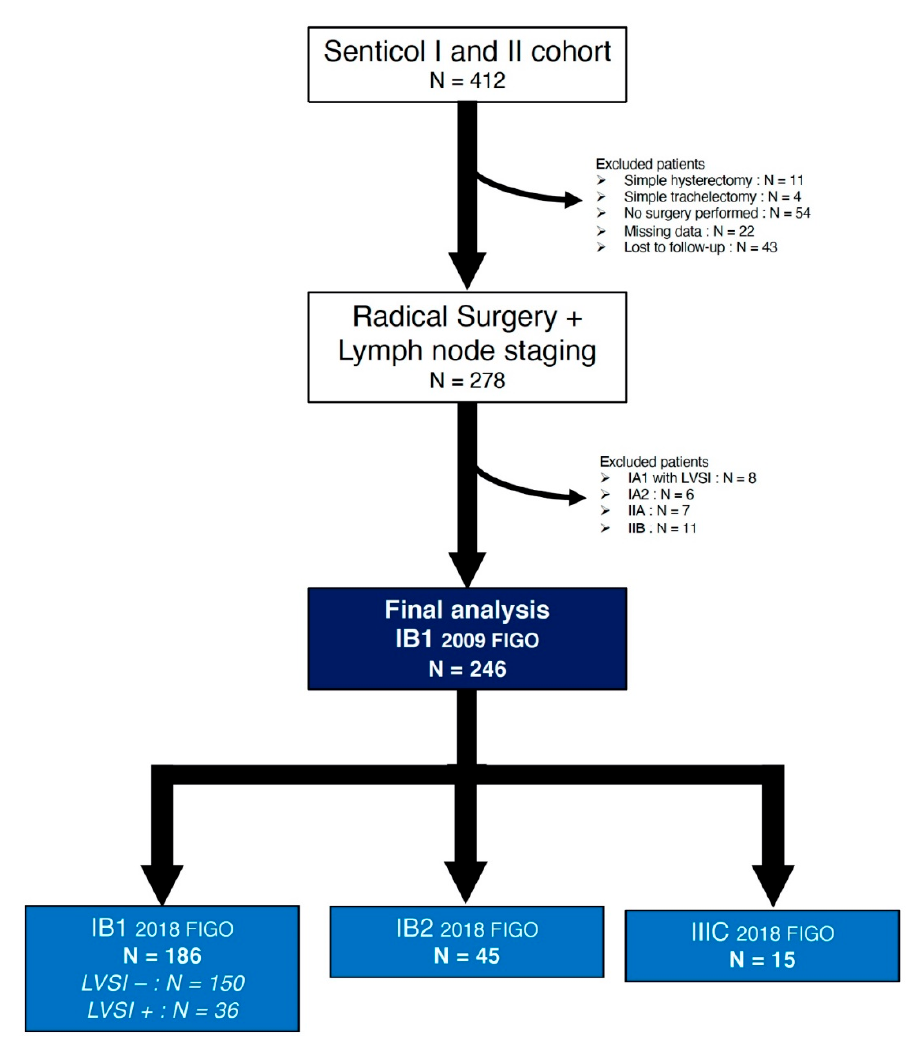
Figure 1. Flow-chart of the population study.